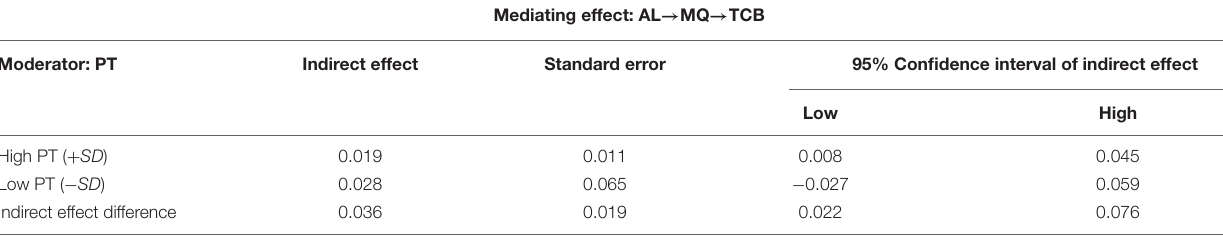
TABLE 4 | Moderated mediating effect